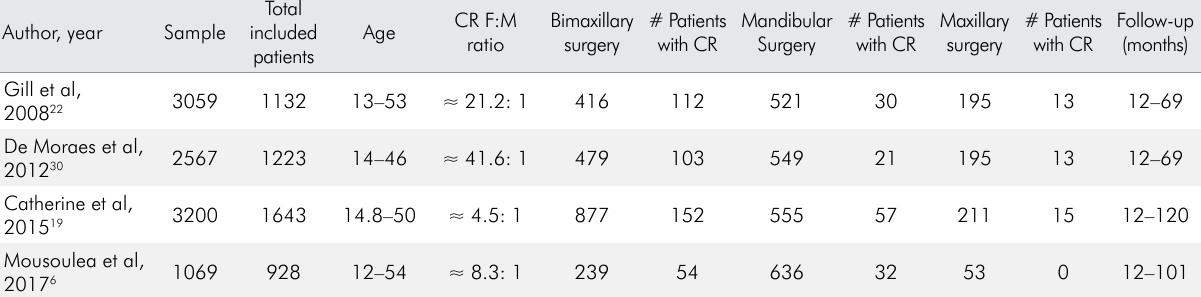
Table 1. Demographic characteristics and incidence of condylar resorption